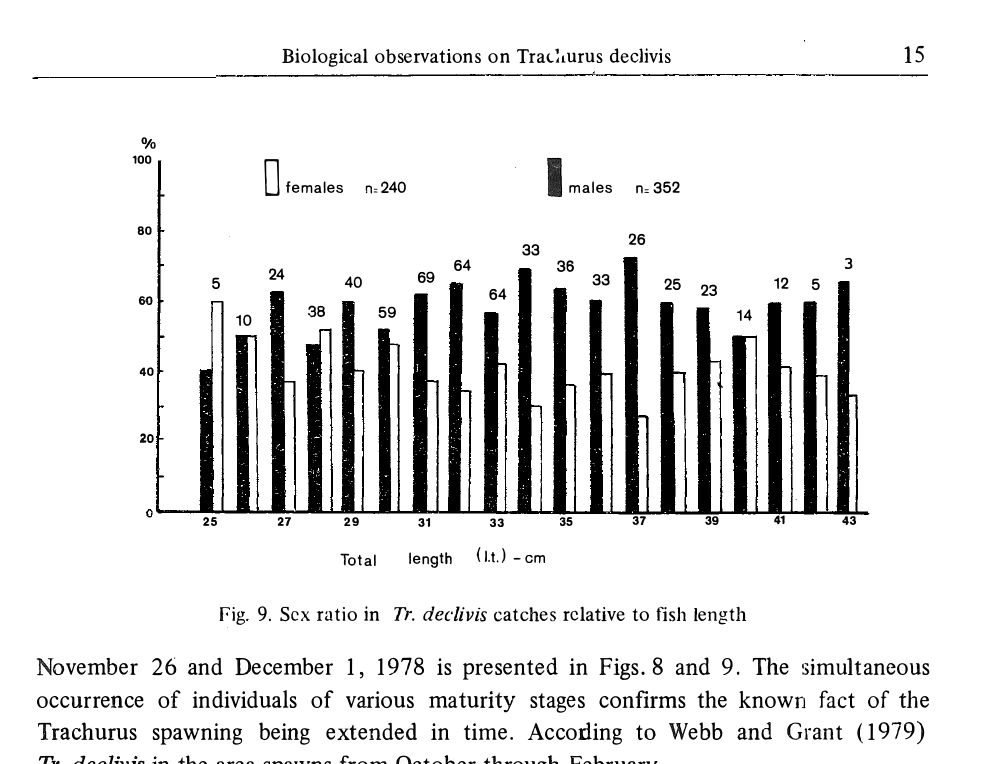
fig. 9. Sex ratio in Tr. declivis catches relative to fish length